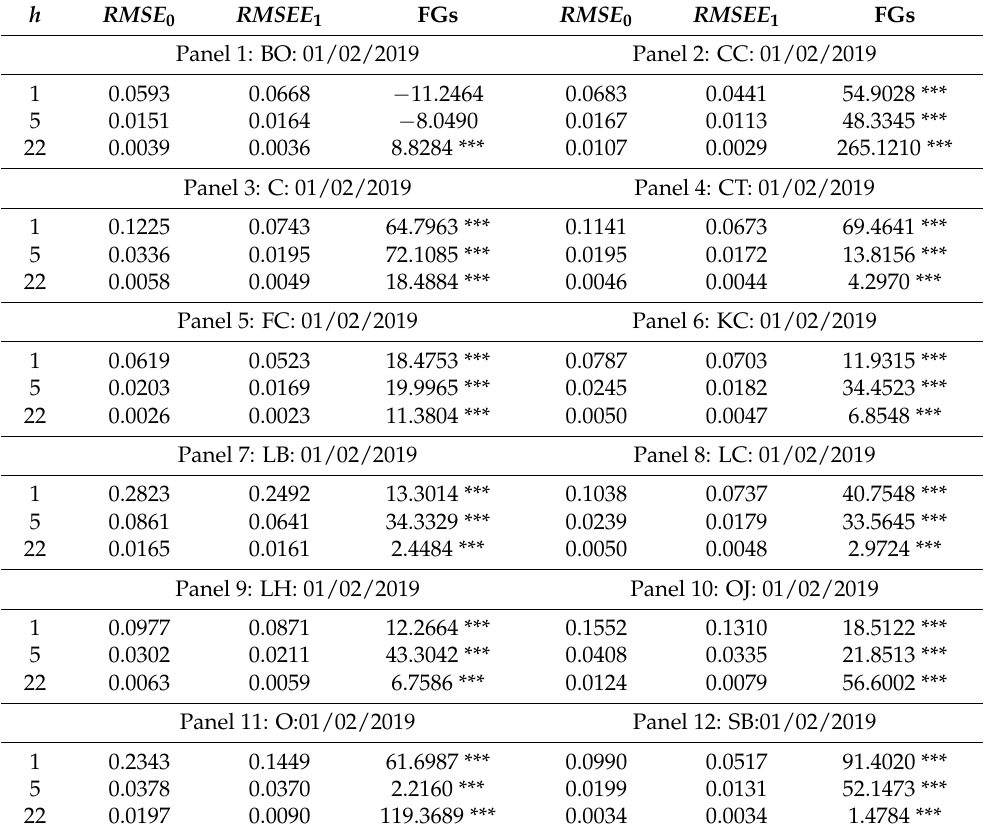
Table 3. COVID-19 episode out-of-sample forecasting